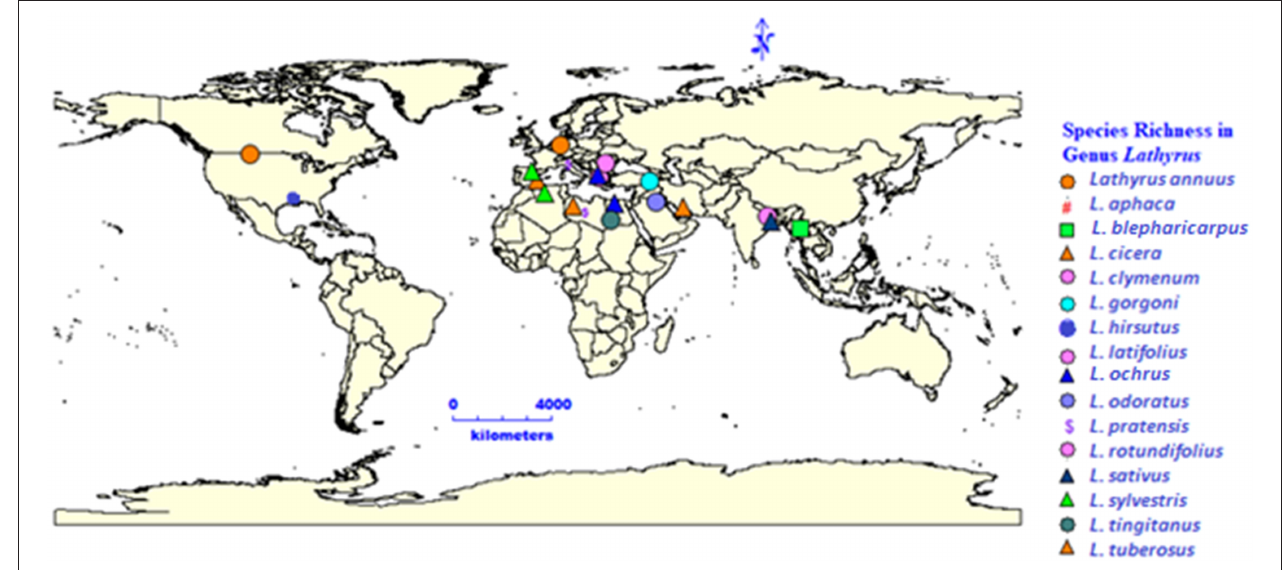
FIGURE 2 | Species richness in genus Lathyrus and its